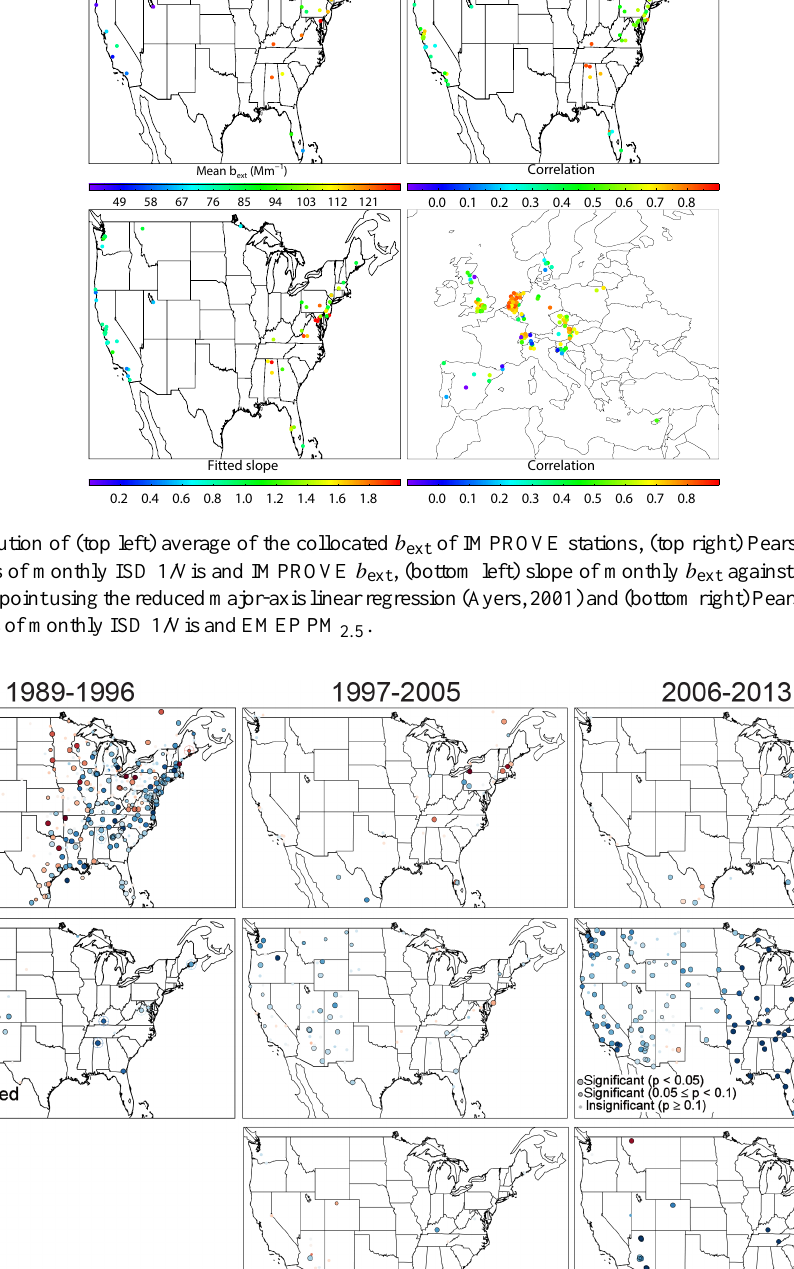
Atmos. Chem. Phys., 16, 2435–2457,